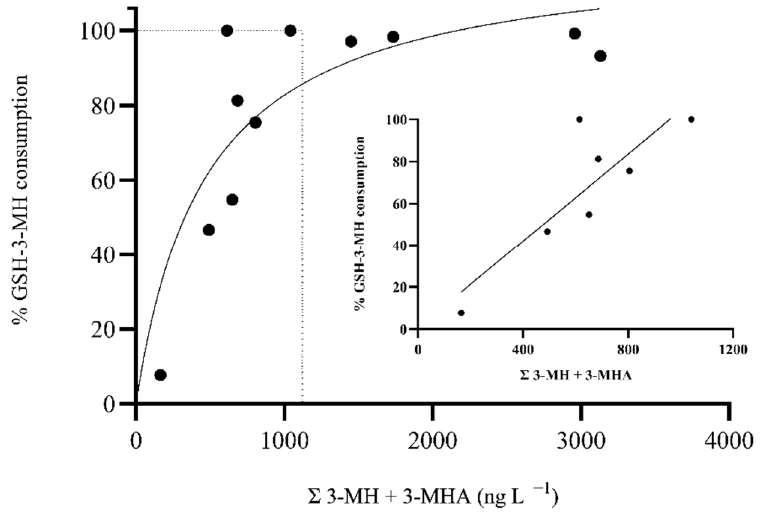
Figure 4. Relationship between the consumption of GSH-3-MH (percentage related to the initial concentration in the must) and free thiol production ( Σ 3-MH and 3-MHA) after fermentation of a Pinot Noir must by 11 wine strains with different IRC7 genotypes. The solid line represents the non-linear least squares fitting curve between variables (r = 0.84). The area under the dotted lines is zoomed in to highlight the linear relationship between these two variables for a subset of 7 strains with low and moderate thiol-releasing abilities (r = 0.85, p = 0.015). Table 3. Effect of different yeast strains in VSC formation after Pinot Noir